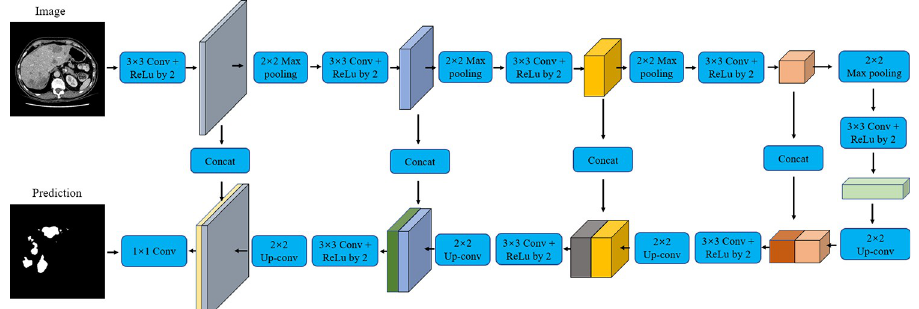
Fig 10. The detailed architecture of the U-Net.